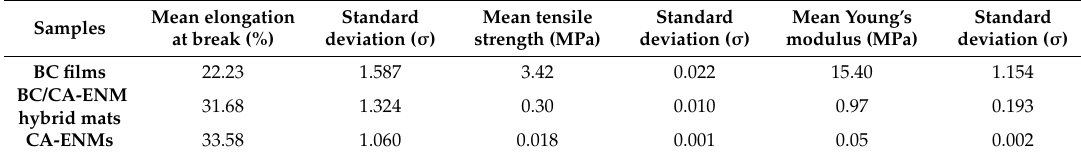
Table 5. Tensile test results for BC films and BC/CA-ENM hybrid mats and CA-ENMs.